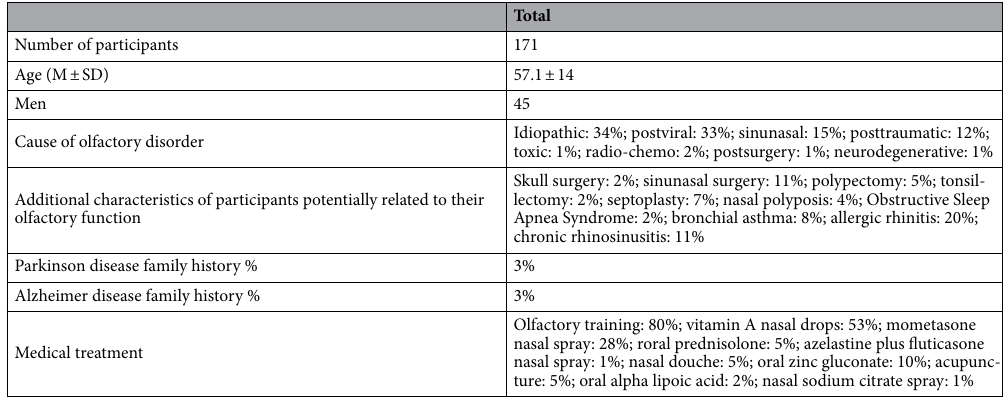
Table 1. Descriptive characteristics of the participants.